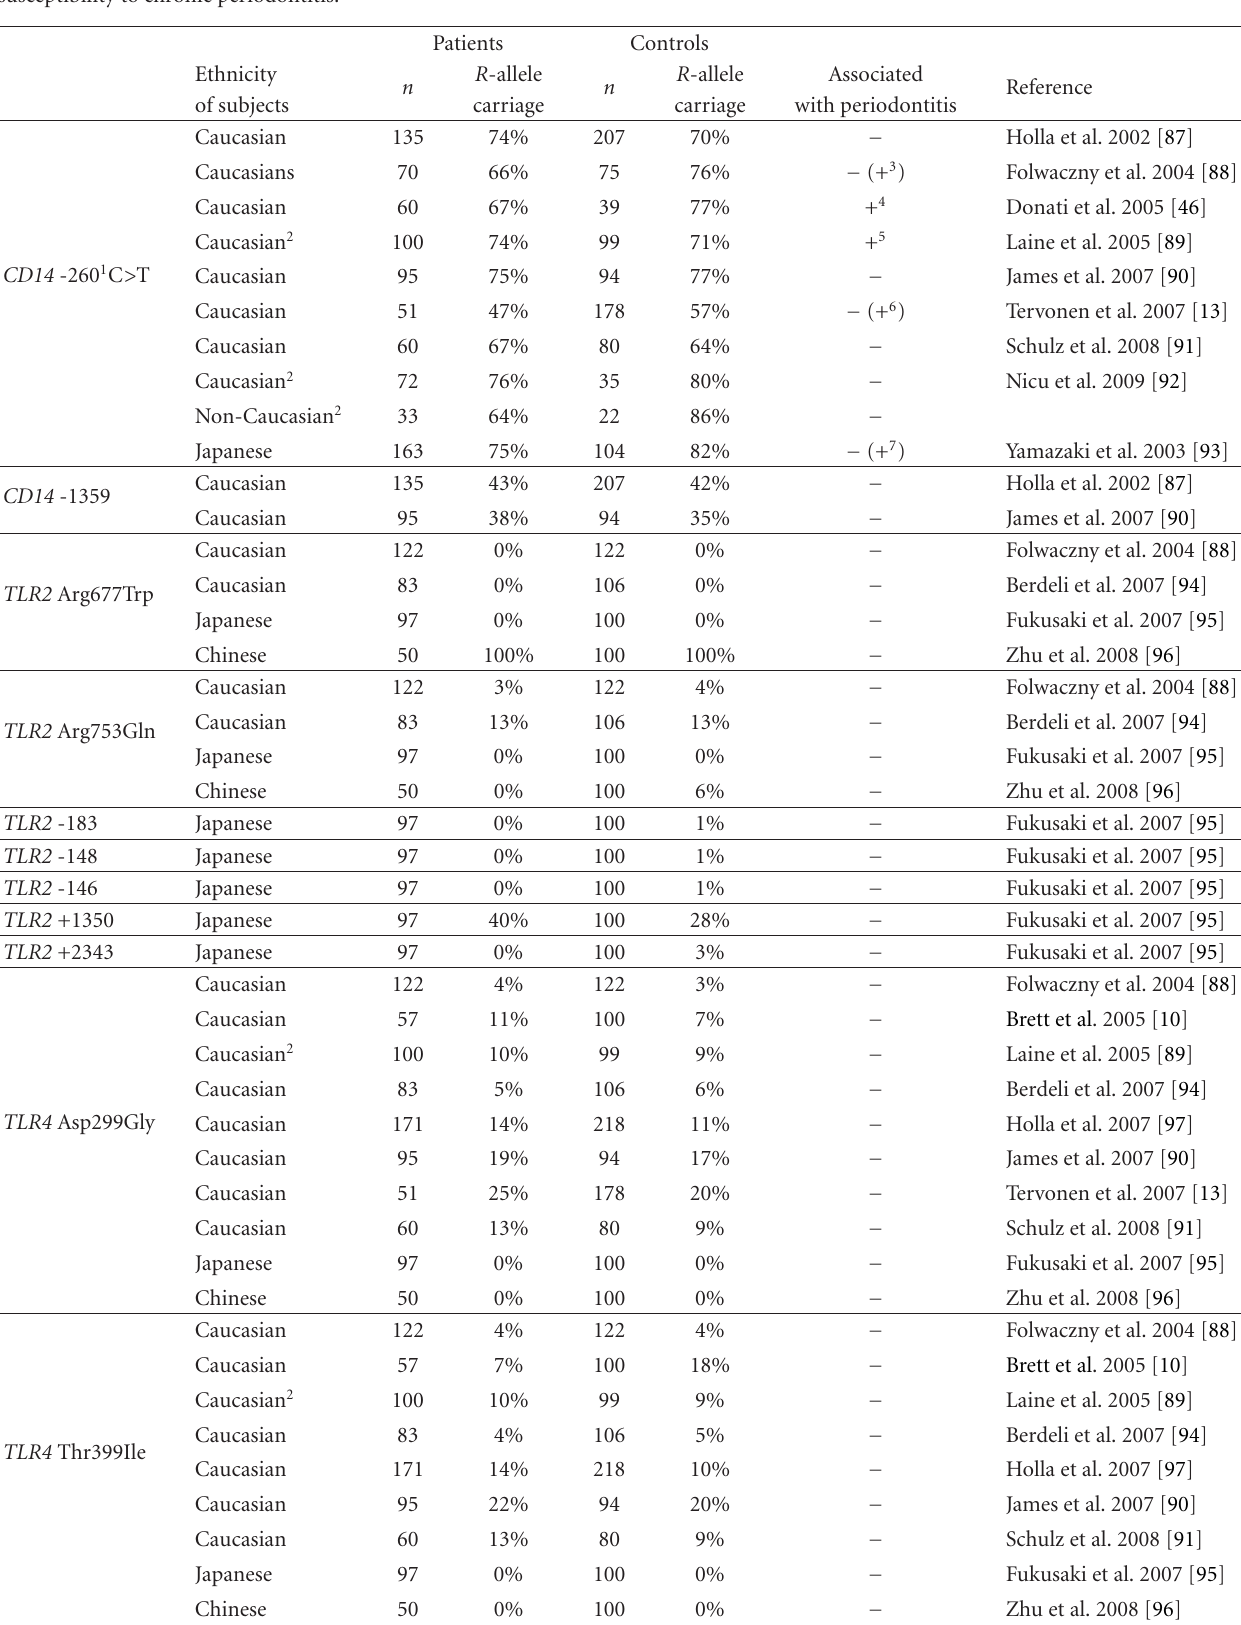
Table 11: CD14, TLR2, and TLR4 gene polymorphisms and carriage rate of the Rare ( R )-allele in case-control studies and association with susceptibility to chronic